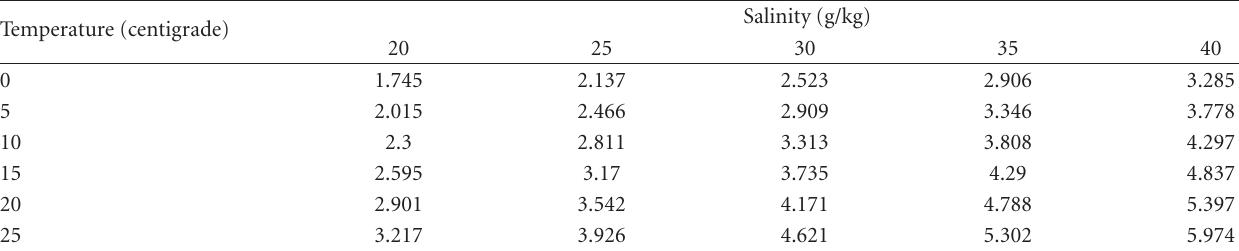
Table 2: Specific conductivity σ of salt water at atmospheric pressure in siemens/meter (source: [37]).